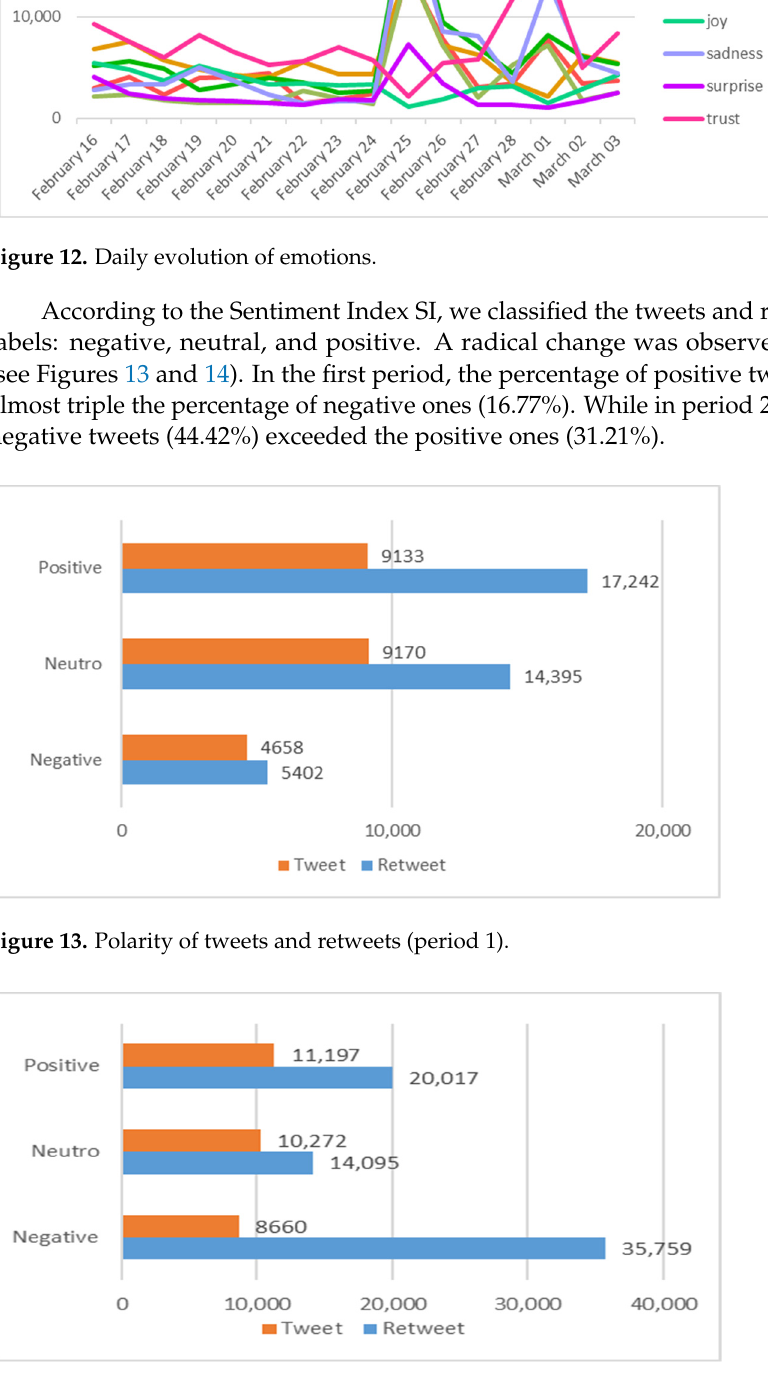
Figure 14. Polarity of tweets and retweets (period 2).